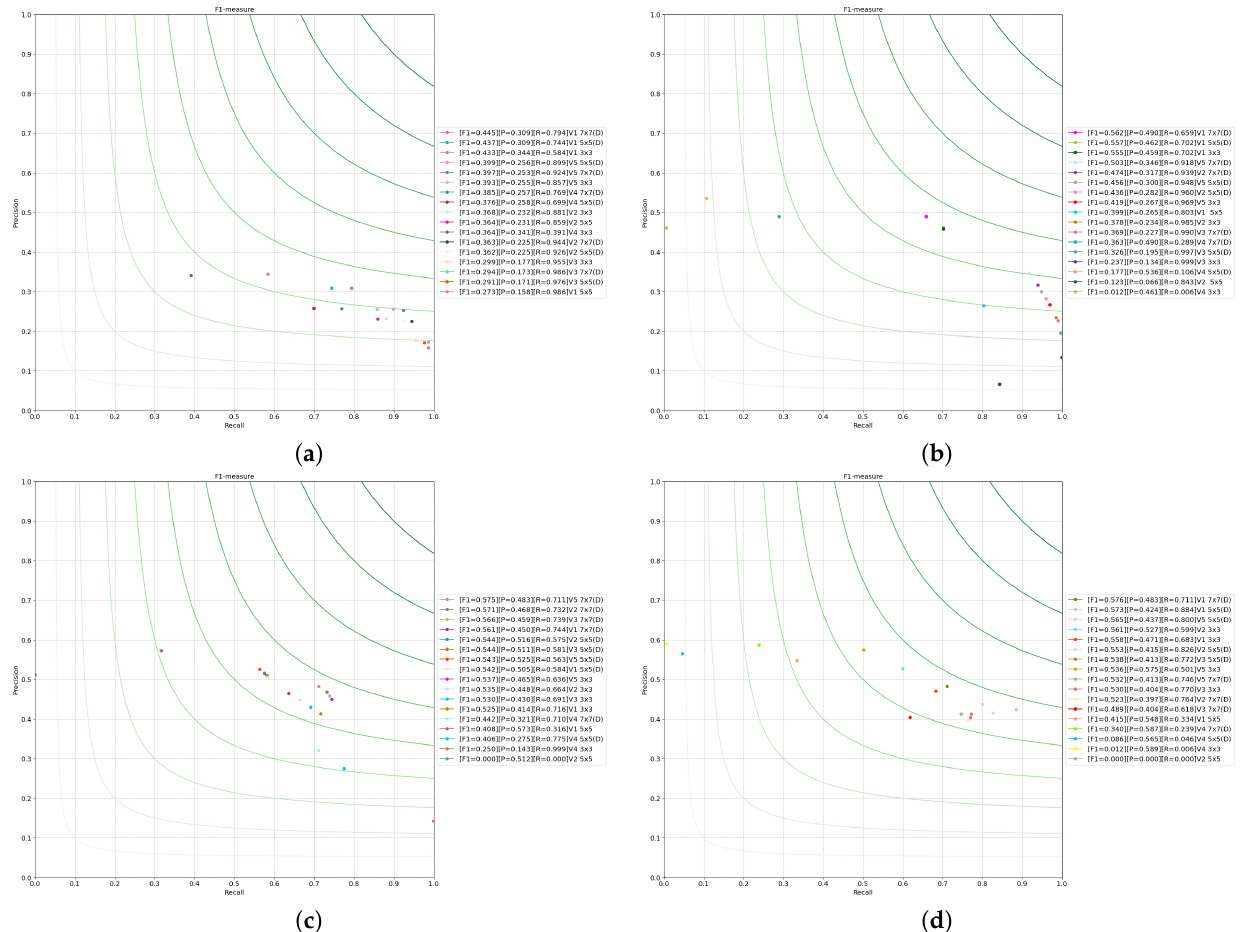
Figure 15. Finding the best results for classic, extended and dilated using different parameters for: ( a ) Laplace edge operator; ( b ) LoG edge operator; ( c ) Marr–Hildreth edge operator; ( d ) Shen–Castan edge